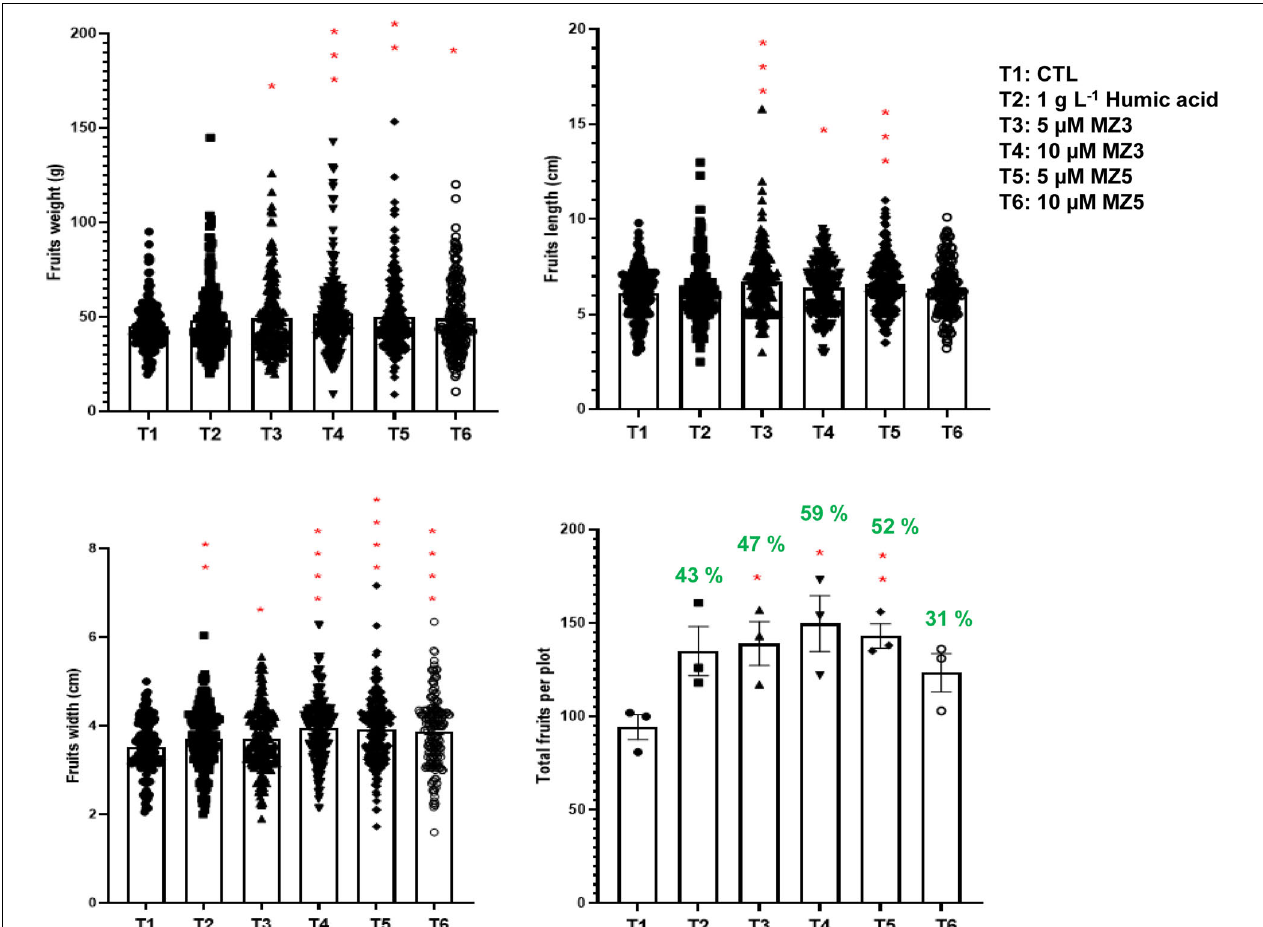
FIGURE 7 | MiZax effect on green pepper fruit production from the KAUST field, performed in 2021. Each data point represents one plant ( n ≥ 166). Data represent mean ± SD . Statistical analysis was performed using the two-tailed Student’s t -test. Asterisks indicate statistically significant differences as compared to CTL (* p < 0.05, ** p < 0.01, *** p < 0.001, **** p < 0.0001). Symbols ( • , CTL; (cid:4) , 1.5 g l − 1 HA; (cid:78) , 5 µ M MZ3; (cid:72) , 10 µ M MZ3; (cid:7) , 5 µ M MZ5; and , 10 µ M MZ5) used over error bars represent each replicates in the investigated group. CTL, Control; HA, humic acid; MZ3, MiZax3; MZ5,